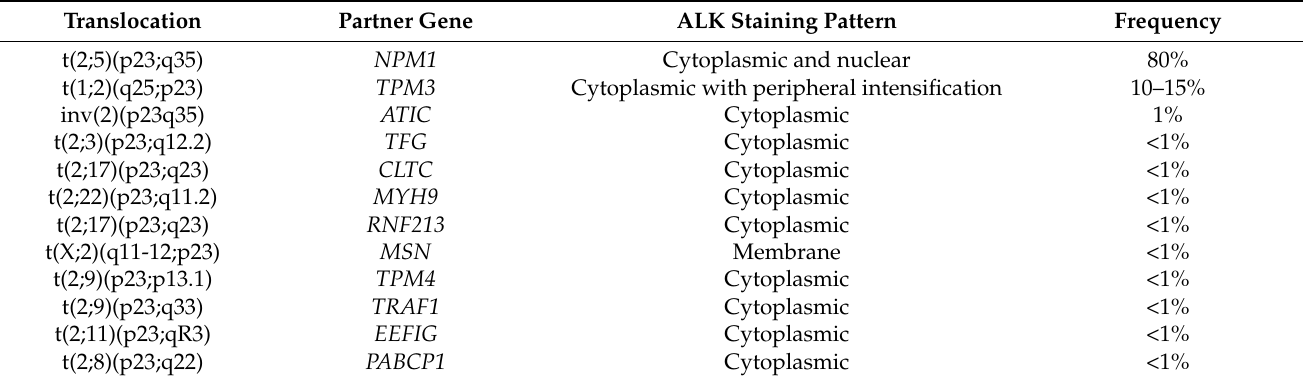
Table 1. Translocations and ALK staining pattern of ALK +